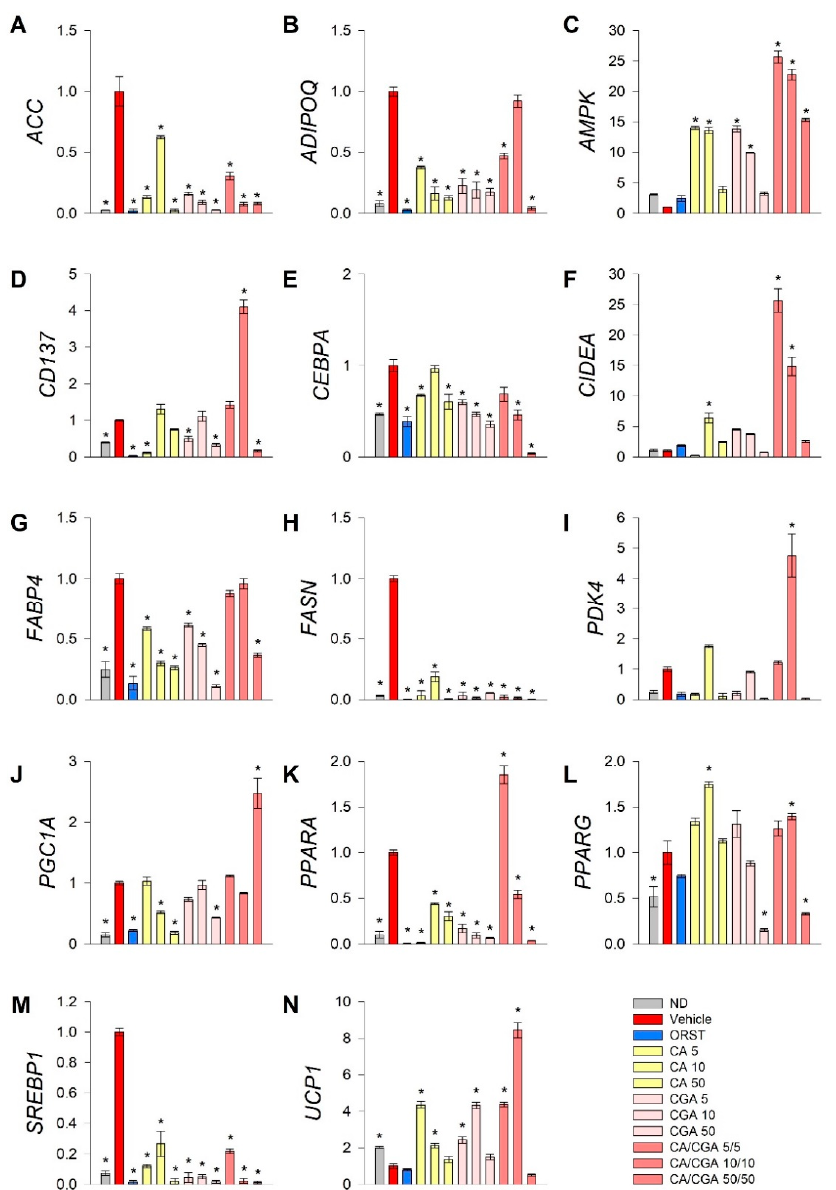
Figure 3. Combined treatment with caffeic and chlorogenic acids altered adipogenic gene expression and induced browning markers’ transcriptional activation in human SGBS adipocytes. Relative mRNA expression ( ∆∆ Cq) normalized to vehicle control group for the following genes: ( A ) acetyl-coA-carboxylase ( ACC ), ( B ) adiponectin ( ADIPOQ ), ( C ) AMP-activated protein kinase ( AMPK ), ( D ) tumor necrosis factor receptor superfamily member 9 ( CD137 ), ( E ) CAAT/enhancer-binding protein alpha ( CEBPA ), ( F ) cell death activator CIDE-A ( CIDEA ), ( G ) fatty acid binding protein 4 ( FABP4 ), ( H ) fatty acid synthase ( FASN ), ( I ) pyruvate dehydrogenase kinase isoform 4 ( PDK4 ), ( J ) peroxisome proliferator-activated receptor gamma co-activator 1 alpha ( PGC1A ), ( K ) peroxisome proliferator-activated receptor alpha ( PPARA ), ( L ) PPARG , ( M ) sterol regulatory element-binding protein 1 ( SREBP1 ) and ( N ) uncoupling protein 1 ( UCP1 ) from the RT-qPCR. RPL13A and TUBB were applied as reference genes. Each sample was analyzed in triplicate from three independent experiments. Data are presented as mean ± SEM. * p < 0.05 compared to the vehicle control group.